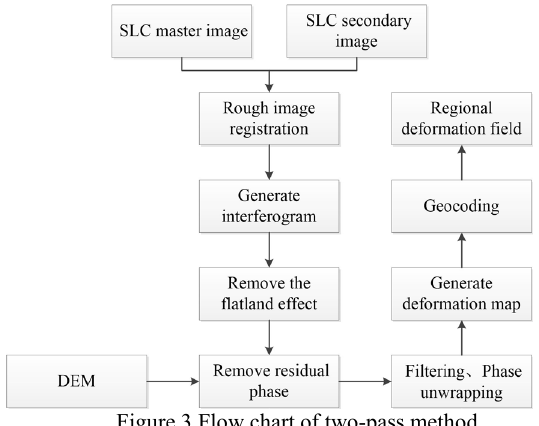
Figure 4. Interference diagram